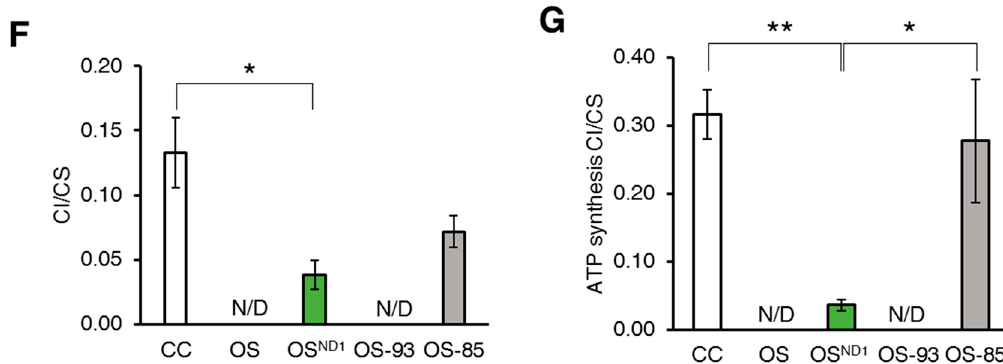
Figure 3. Low levels of wild type ND1 partially rescue CI assembly and function. ( A ) Western blot analysis of ND1 levels in crude mitochondria from control (CC), ND1-null (OS), 93% ND1 mutant (OS-93), 85% ND1 mutant (OS-85) and allotopically complemented (OS ND1 ) cybrids. VDAC1 was used as loading control. One representative experiment of three is shown. ( B ) Mitochondrial in vitro translation. The autoradiogram displaying the radiolabeled mitochondrial translation products and the corresponding Coomassie blue-stained gel as a control for loading are shown. The boxed section correspond to the endogenous ND1 subunit. A small protein product of about 15 kDa, indicated by an asterisk, is detectable in OS ND1 . This band may be the bona fide truncated ND1 subunit. ( C ) Western blot analysis of steady state levels of CI nuclear-encoded subunits in crude mitochondria from control (CC), ND1-null (OS), 93% ND1 mutant (OS-93), 85% ND1 mutant (OS-85), and allotopically complemented (OS ND1 ) cybrids. VDAC1 was used as a loading control. One representative experiment of three is shown. ( D ) 2D BN/SDS-PAGE followed by western blotting using an antibody against NDUFS3 subunit performed on mitochondria-enriched fractions. Fully assembled CI and sub-complexes (Sb1-2-3) are indicated by dotted lines. One representative experiment of three is shown. ( E ) CI-IGA assay after separation of mitochondria-enriched fractions by hrCNE. One representative experiment of three is shown. ( F ) CI redox specific activity (rotenone-sensitive) normalized on citrate synthase (CS) activity. Data are mean ± SD ( n = 5, * p -value < 0.05). ( G ) Mitochondrial ATP synthesis rate driven by CI substrates. Data are normalized on CS activity and are mean ± SD ( n = 5, * p -value < 0.05; ** p -value < 0.001).